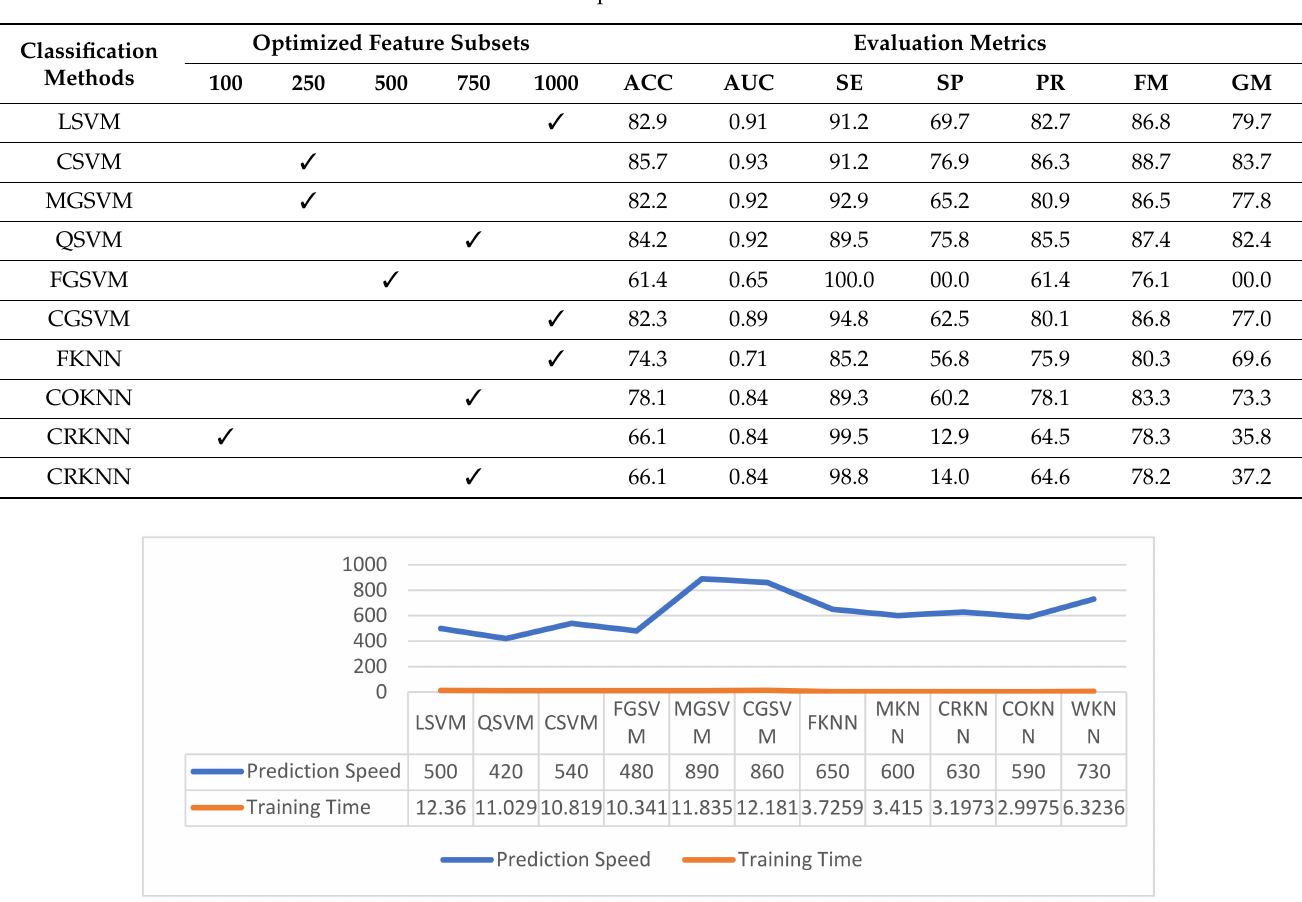
Table 12. Front view-based experimental results on PKU-Reid dataset.